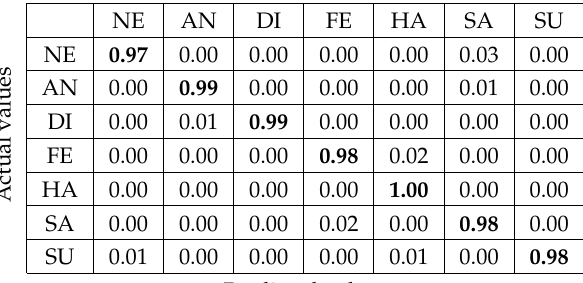
Table 9. Confusion matrix of joint fusion classifier in the CK+ dataset. NE, Neutral; AN, Angry; DI, Disgust; FE, Fear; HA, Happy; SA, Sad; SU, Surprise.